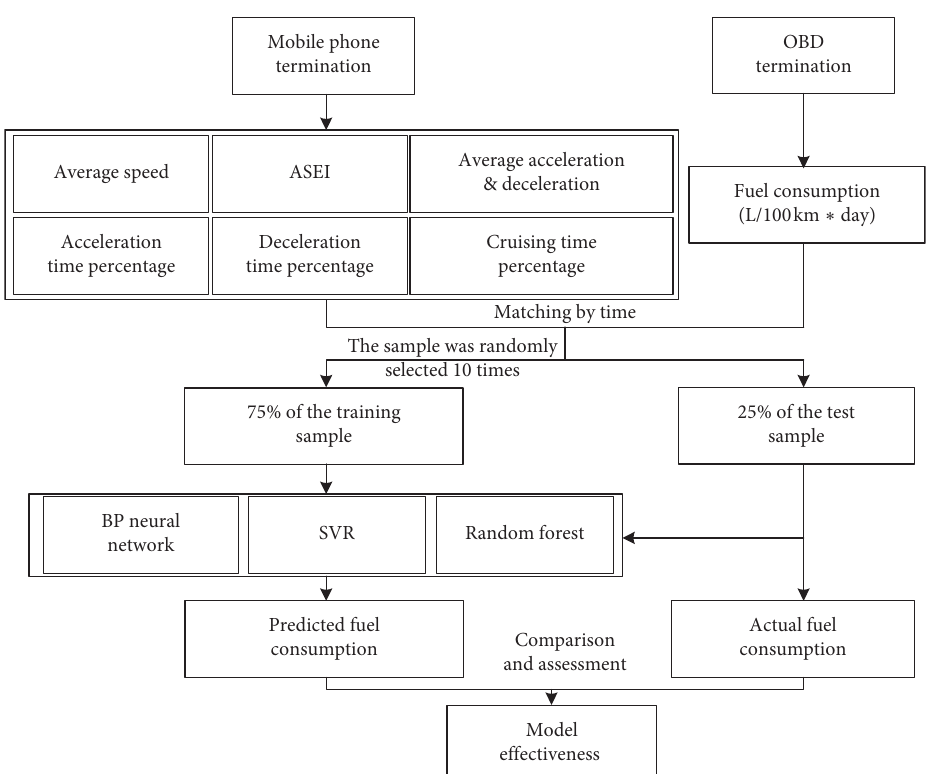
Figure 6: The process of building the fuel consumption prediction model.